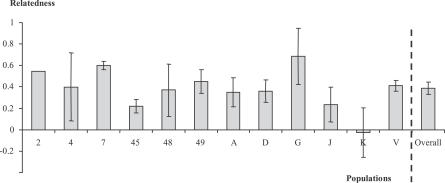
Mean Relatedness (± SE) among Genotypes within Plants, Overall, and for Each Population